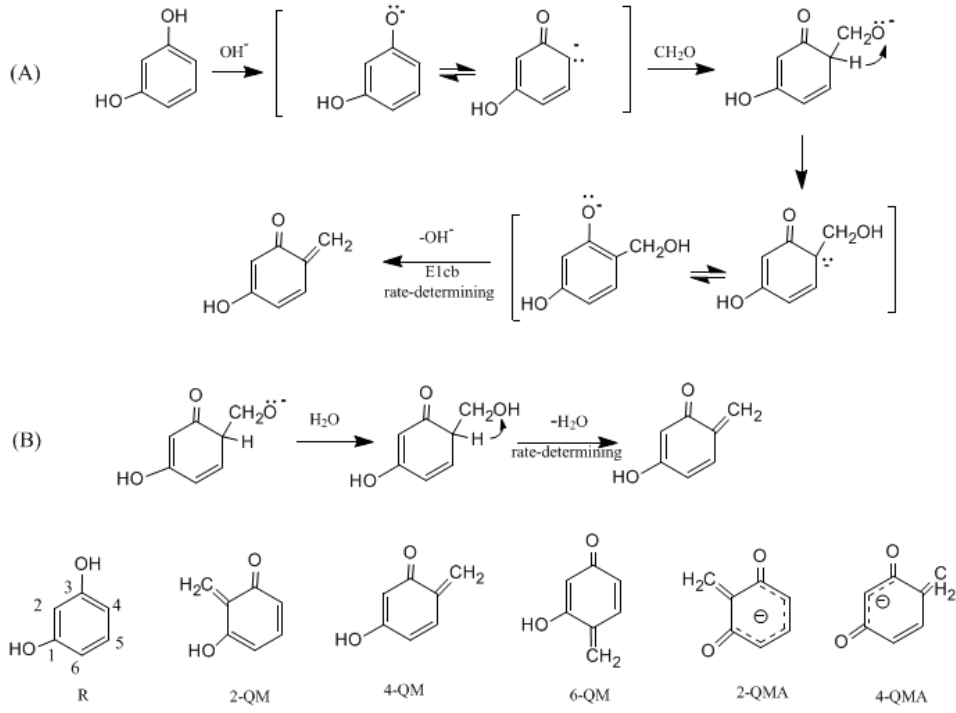
Figure 1. The proposed mechanisms for formation of resorcinol quinonemethides.